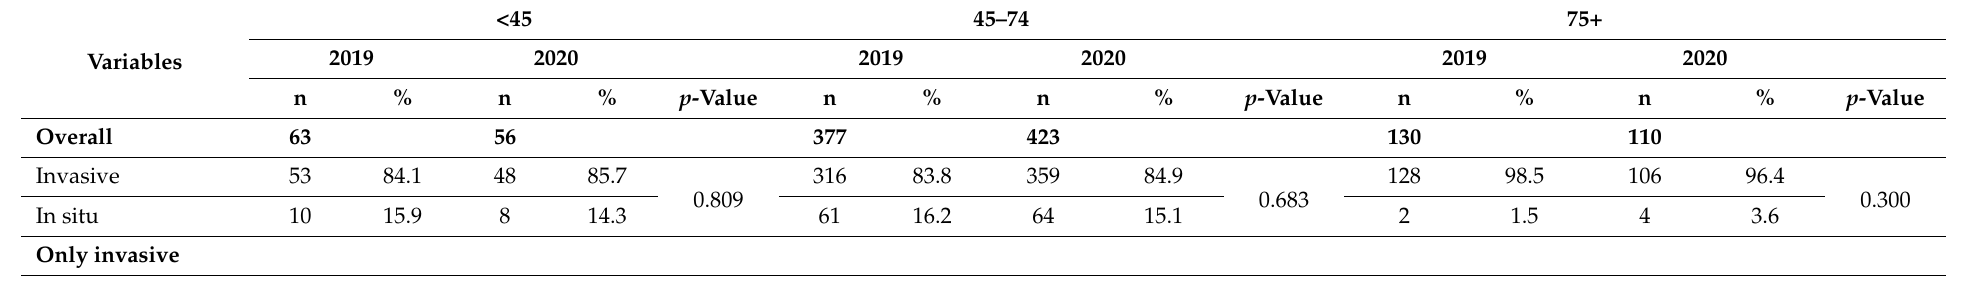
Table 2. Characteristics of women with breast cancer, by year of diagnosis and